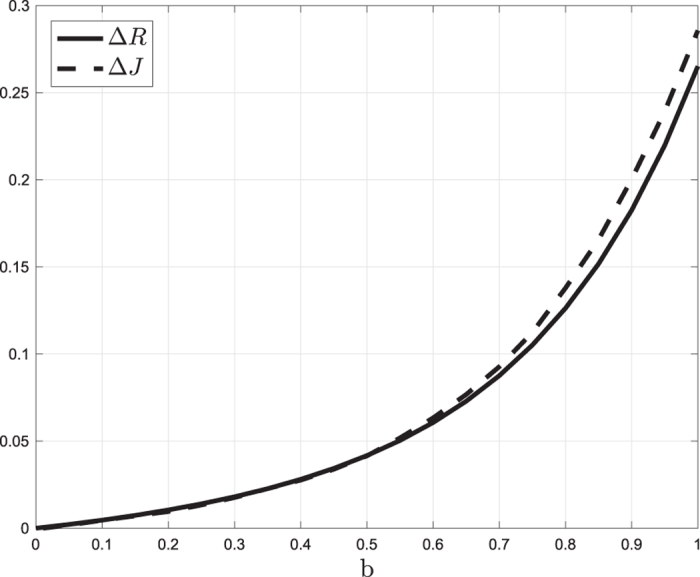
ΔR and ΔJ as a function of b in Example 2.